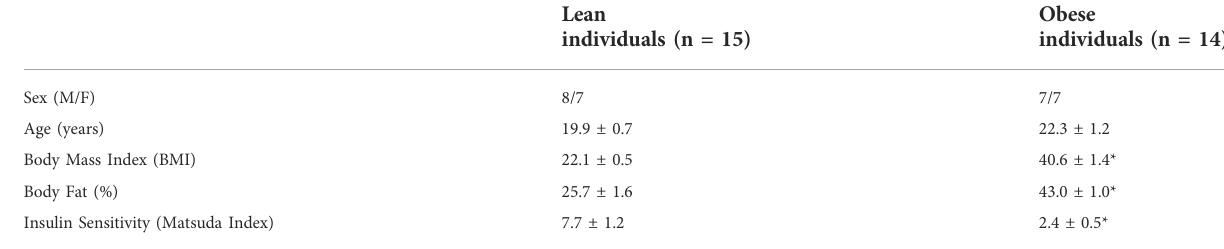
TABLE 1 Participant characteristics.